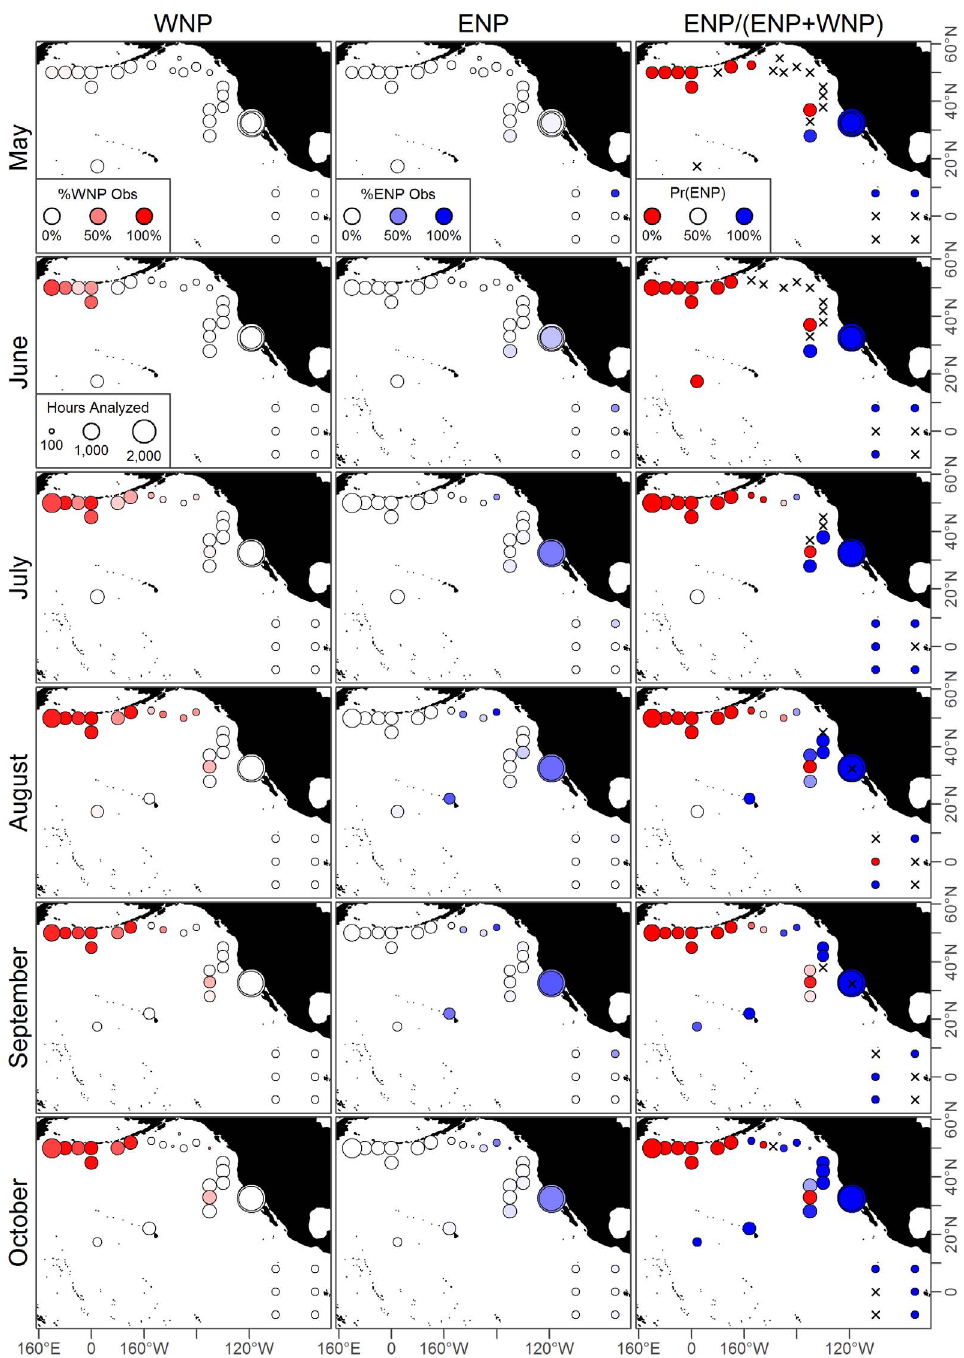
Figure 4. Observed hydrophone data for May-October. These data are used to fit separate acoustic models for both populations. Colored circles show hydrophones and the proportion of hours calls were observed while and ‘‘x’’ denotes those with no observed calls for either population. The western population migrates east along the Aleutian Islands and the eastern population migrations northwest into the North Pacific. Hydrophones with observed calls from both populations clearly show overlap for much of the North